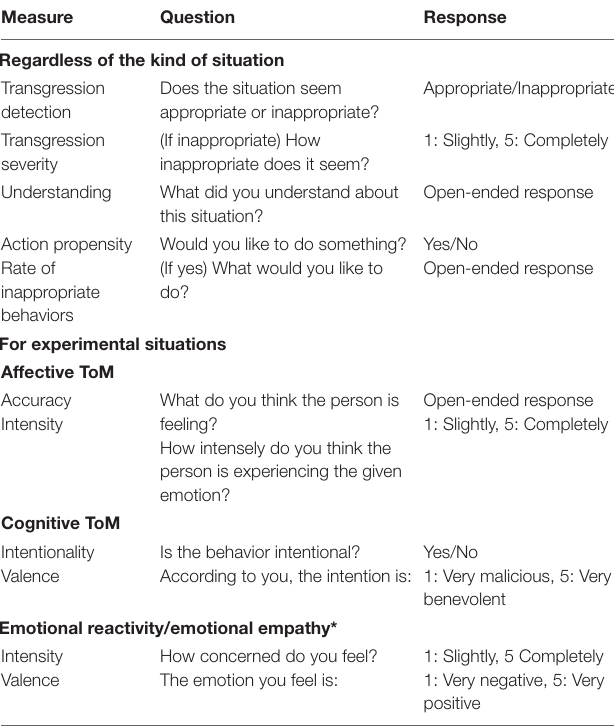
TABLE 2 | Sociocognitive processes assessed during the REALSoCog